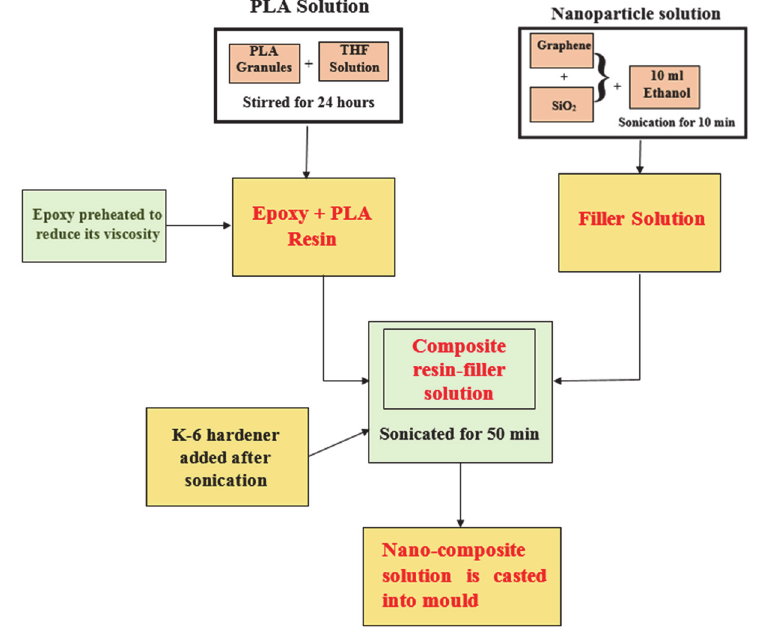
Figure 1 : Steps in preparation of nanocomposites.